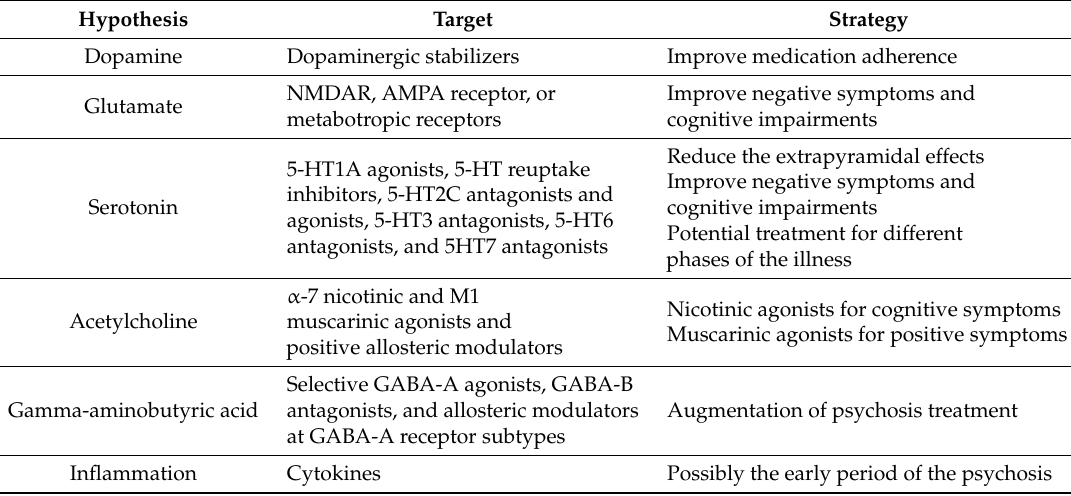
Table 1. Novel treatment targets for